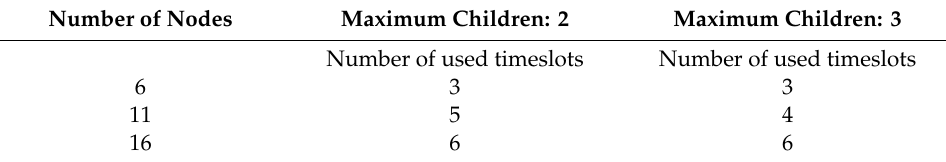
Table 3. The number of timeslots used in the experiment scenario. Table 4. E2E delay average (timeslot).